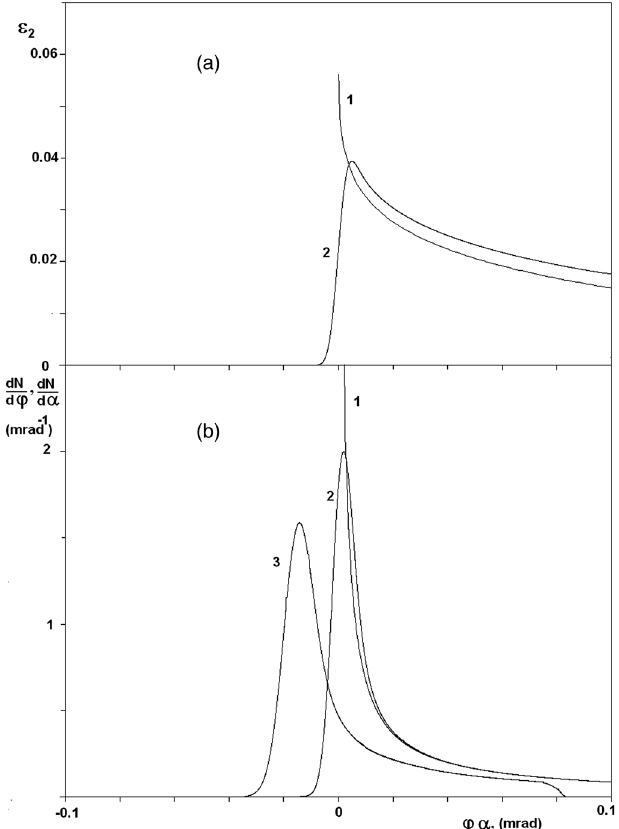
FIG. 7. The total and partial distributions F 0 ; F a ; F b as functions of the ξ -parameter for bending radii equal to 5, 10, FIG. 8. Intensity of channeling fraction (a) and differential 15 m (curves 1,2,3, respectively). Here ξ -parameter represents particles losses due to dechanneling (b) as functions of the angle ¯ E φ . Curves 1 and 2 correspond to considerations without and with mean energy losses of particle at volume reflection in units of the transverse energy period δ E . F 0 ¼ F a þ F b . The curves labeled multiple scattering. Curve 3 corresponds to the angle distribution (over α -angle) dechanneling fraction on the entrance of a single as 0 and 00 correspond to F a ; F b -distributions and the thick curves to the F 0 one. The energy of a proton beam is equal to 400